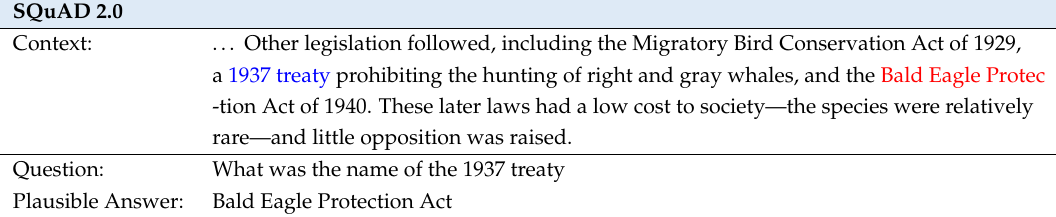
Table 12. Unanswerable question example in SQuAD